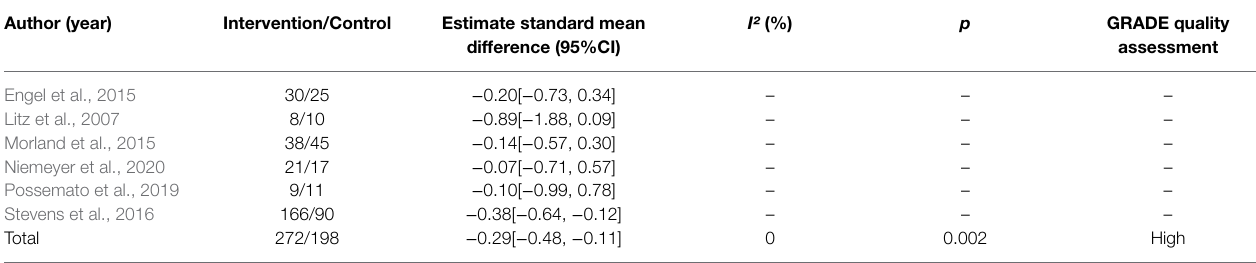
TABLE 2 | Summary of overall effectiveness of IBI on veterans with